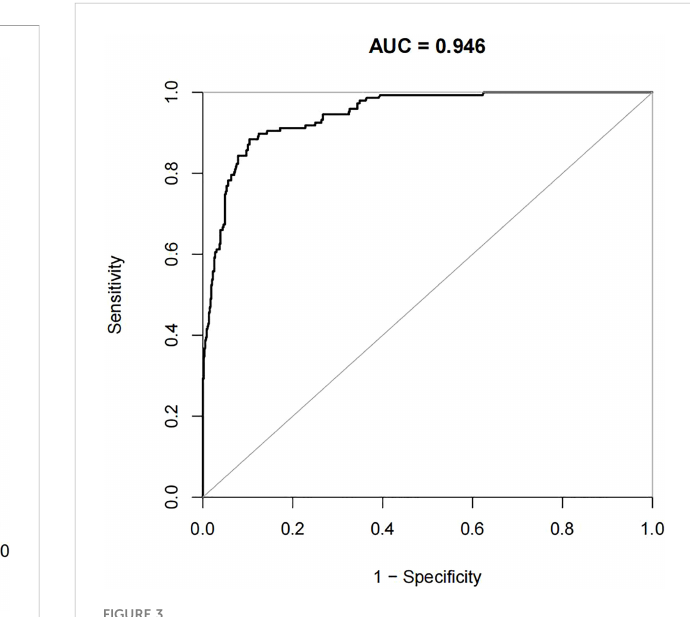
FIGURE 3 The AUC of the prediction model for GDM by XG Boost ML. AUC, area under the receiver operating characteristic curve; GDM, gestational diabetes mellitus; XG Boost ML, extreme gradient boosting (XG) machine learning